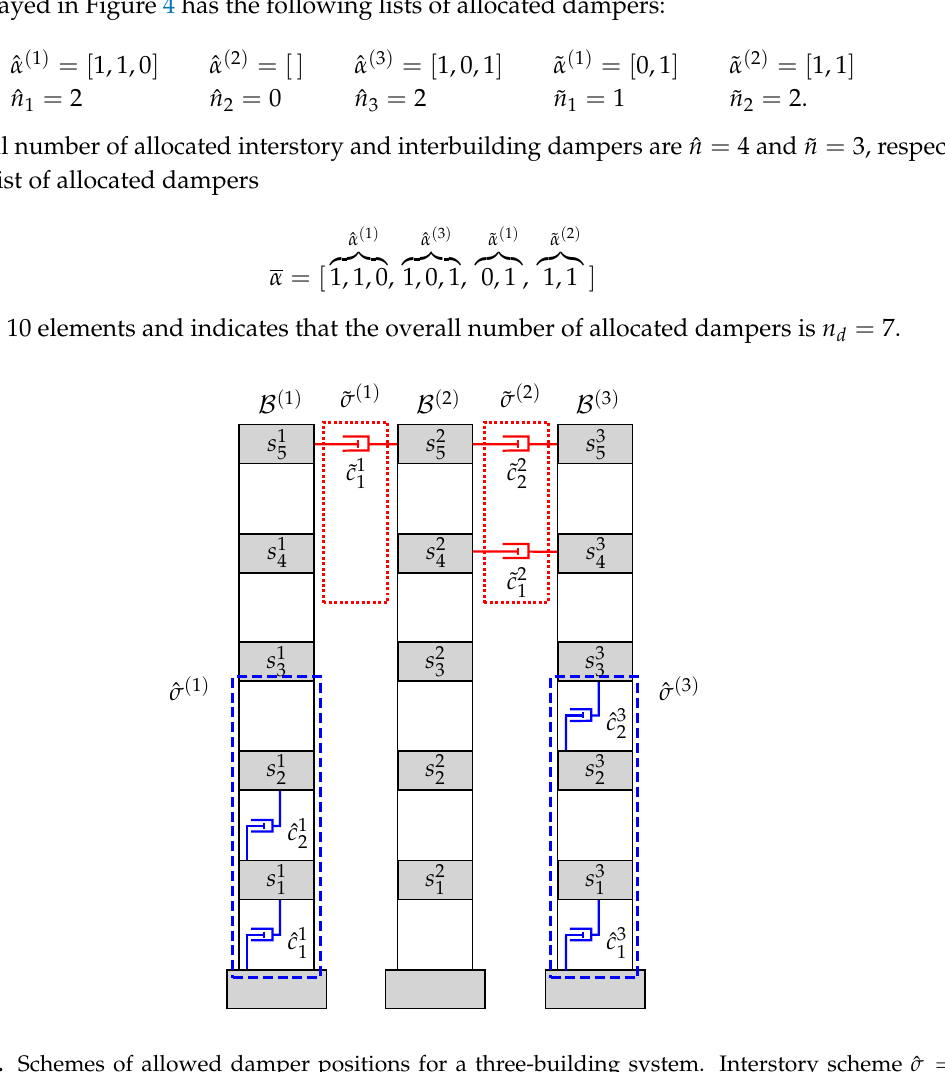
Figure 4. Schemes of allowed damper positions for a three-building system. Interstory scheme ˆ σ = [ ˆ σ ( 1 ) , ˆ σ ( 2 ) , ˆ σ ( 3 ) ] with ˆ η 1 = 3, ˆ η 2 = 0 and ˆ η 3 = 3 (blue dashed rectangles). Interbuilding scheme ˜ σ = [ ˜ σ ( 1 ) , ˜ σ ( 2 ) ] with ˜ η 1 = 2 and ˜ η 2 = 2 (red dotted